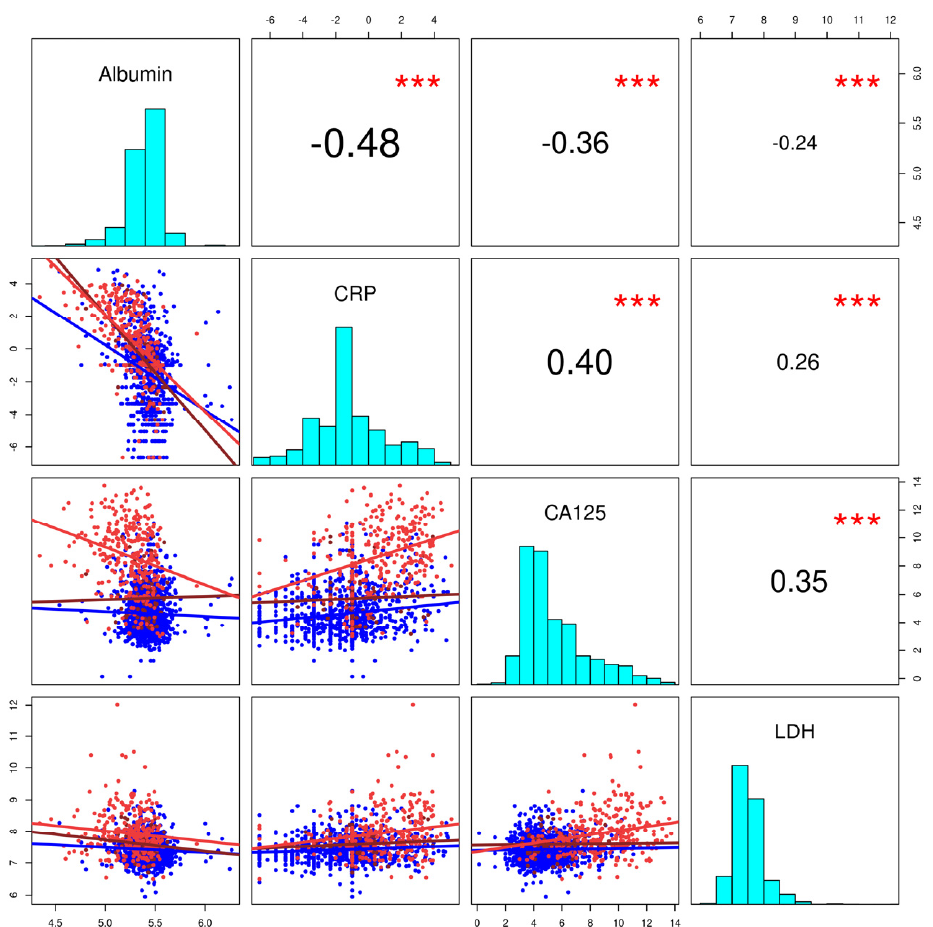
Figure 2. Correlation between albumin, CRP, CA125, and LDH (Log 2 values) in two imputed datasets showing comparable results. Red dots, epithelial ovarian cancer (EOC); petrol dots, borderline tumor of the ovary; blue dots, benign; *** p < 0.001.